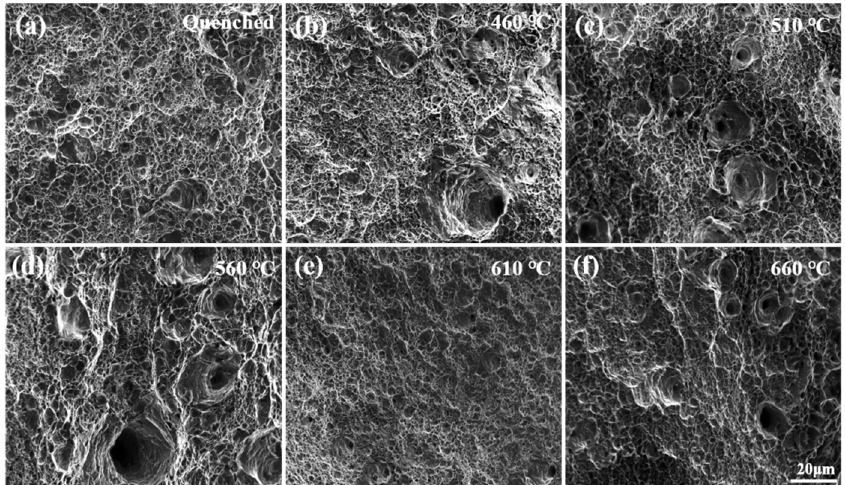
Figure 5. Tensile fracture micromorphology images of the Fe-9Ni-2Cu steel with the increase of temperatures. ( a ) Quenched; ( b ) 460 °C; ( c ) 510 °C; ( d ) 560 °C; ( e ) 610 °C; ( f ) 660 °C. temperatures. ( a ) Quenched; ( b ) 460 ◦ C; ( c ) 510 ◦ C; ( d ) 560 ◦ C; ( e ) 610 ◦ C; ( f ) 660 ◦